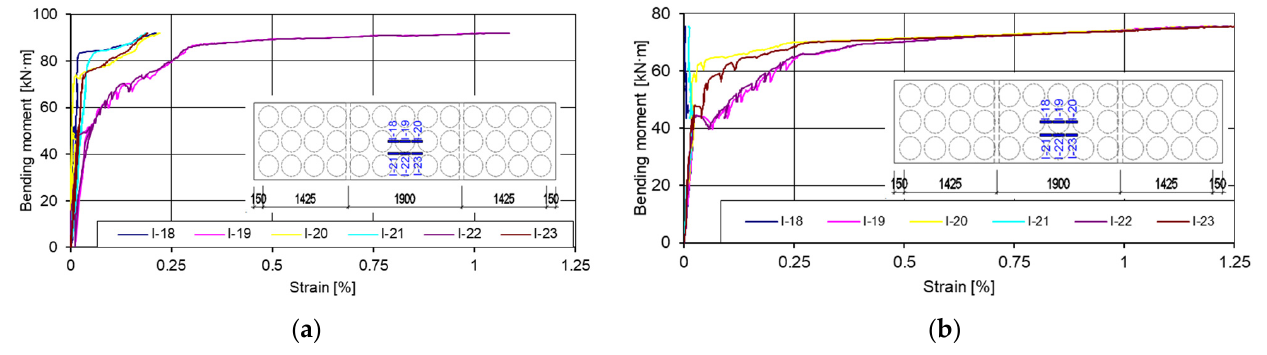
Figure 24. Graphs of bending moments: strains in the tensile zone of the slabs. ( a ) First slab (I pl); ( b ) second slab (II pl).